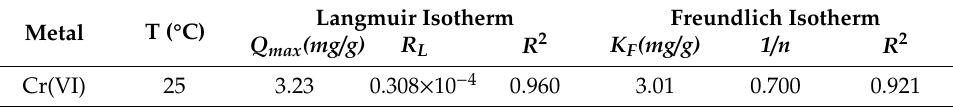
Figure 13. The Freundlich isotherm of Cr(VI) adsorption on the SDS-chitosan beads. Table 4. Isotherm parameters for Cr(VI) adsorption onto the SDS beads.